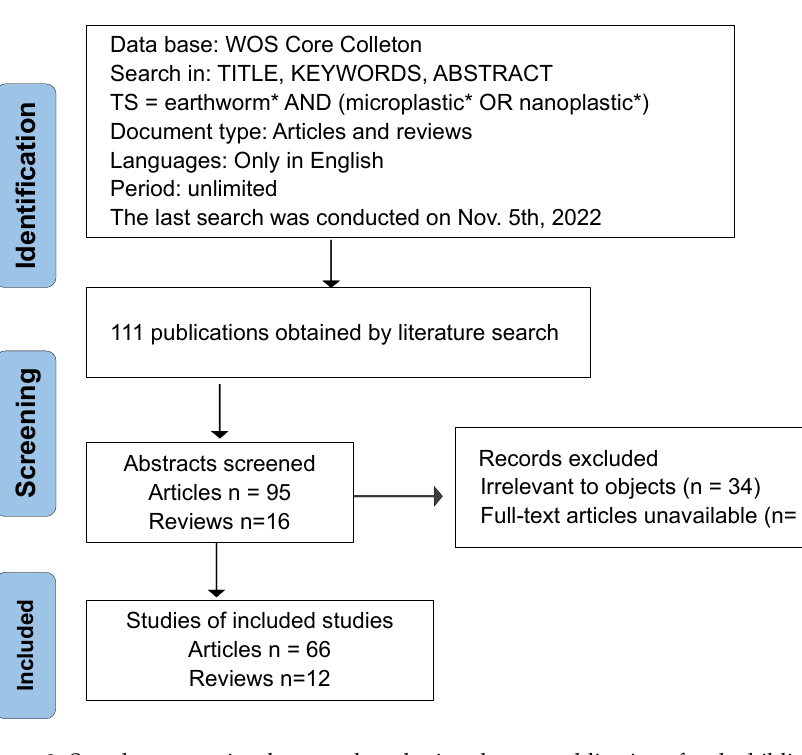
Figure 1. Search strategy implemented to obtain relevant publications for the bibliometric analysis (n denotes the number of publications at the different filtering stages).